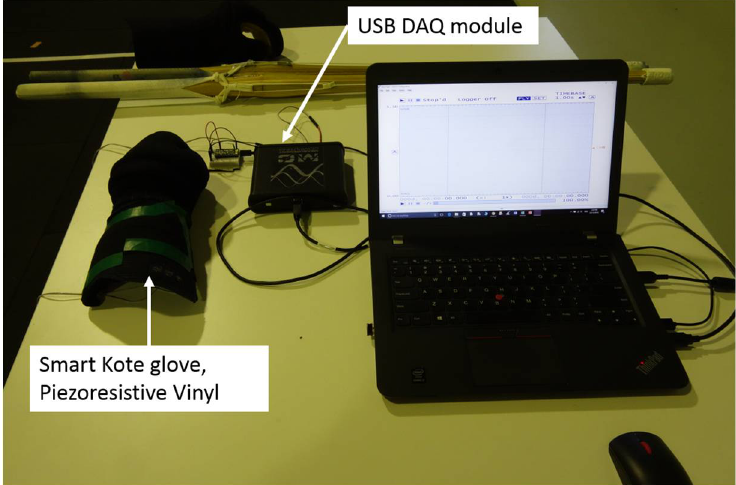
Figure 2. Experiment set up: in-house developed pressure sensor for Kote glove and DAQ